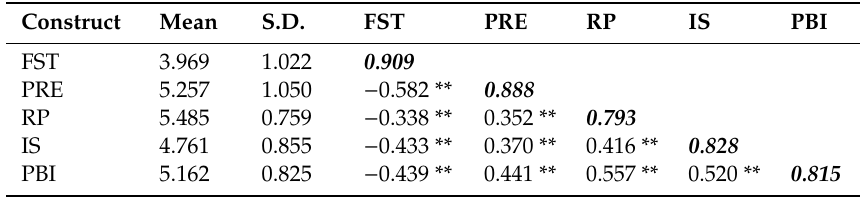
Table 3. Means, standard deviation, and correlations.